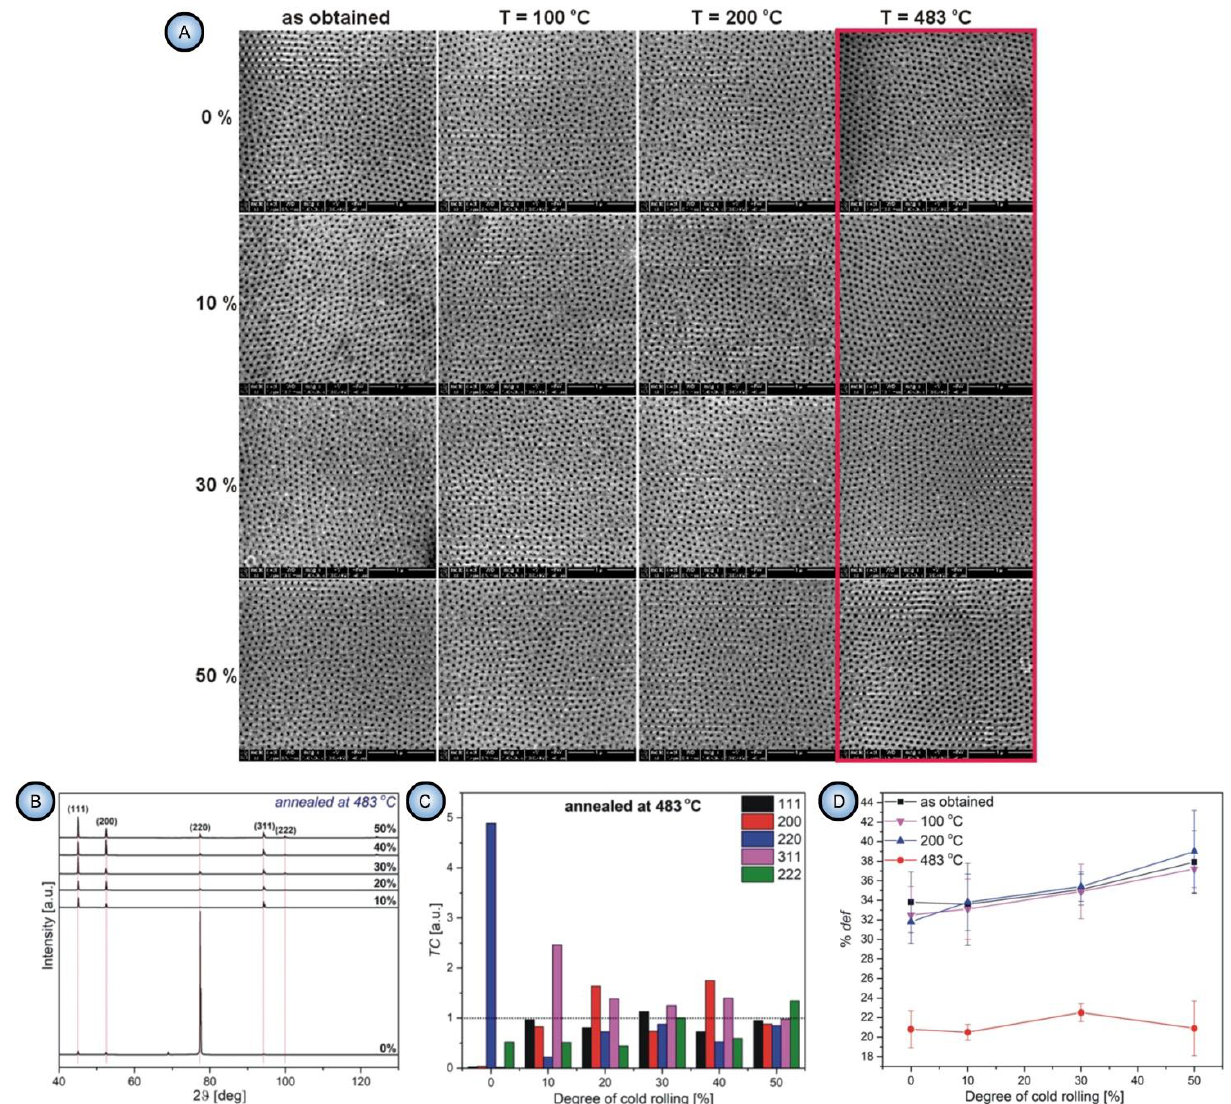
Figure 11. ( A ) SEM micrographs demonstrating different degrees of pore ordering in PAA laminas formed on Al substrates prepared by mechanical deformation (cold rolling to 10–50% thickness reduction) combined with thermal treatment (the temperatures of 100 and 200 ◦ C correspond to the lattice strain relaxation, 483 ◦ C is the temperature of Al recrystallization). ( B ) X-ray diffraction patterns of Al substrates annealed at the recrystallization temperature after different degrees of mechanical treatment. ( C ) A comparison of the preferential grain orientation in different Al samples annealed at 483 ◦ C quantified by using the texture coefficient (TC) along every diffraction plane (a higher value of TC (hkl) > 1 indicates a higher preference of orientation along the corresponding plane). ( D ) The relationships between the degrees of mechanical deformation and the resulting percentages of defects in PAA pore arrangements obtained for Al substrates annealed at different temperatures. Adapted with permission from [103]. Copyright 2019 Elsevier.